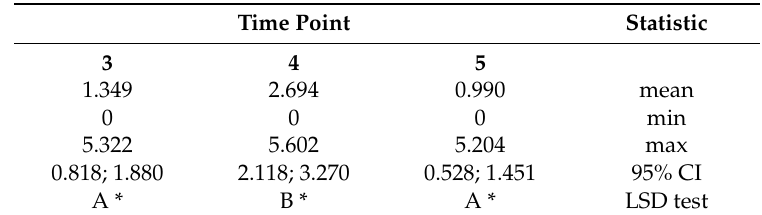
Table 3. Descriptive statistics for rearing period two and three with the respective mean, minimum, and maximum, as well as 95% confidence interval (CI) presented as log CFU/g caecal content at each sampling point for quantitative analysis and the result of the least significant difference (LSD) test.